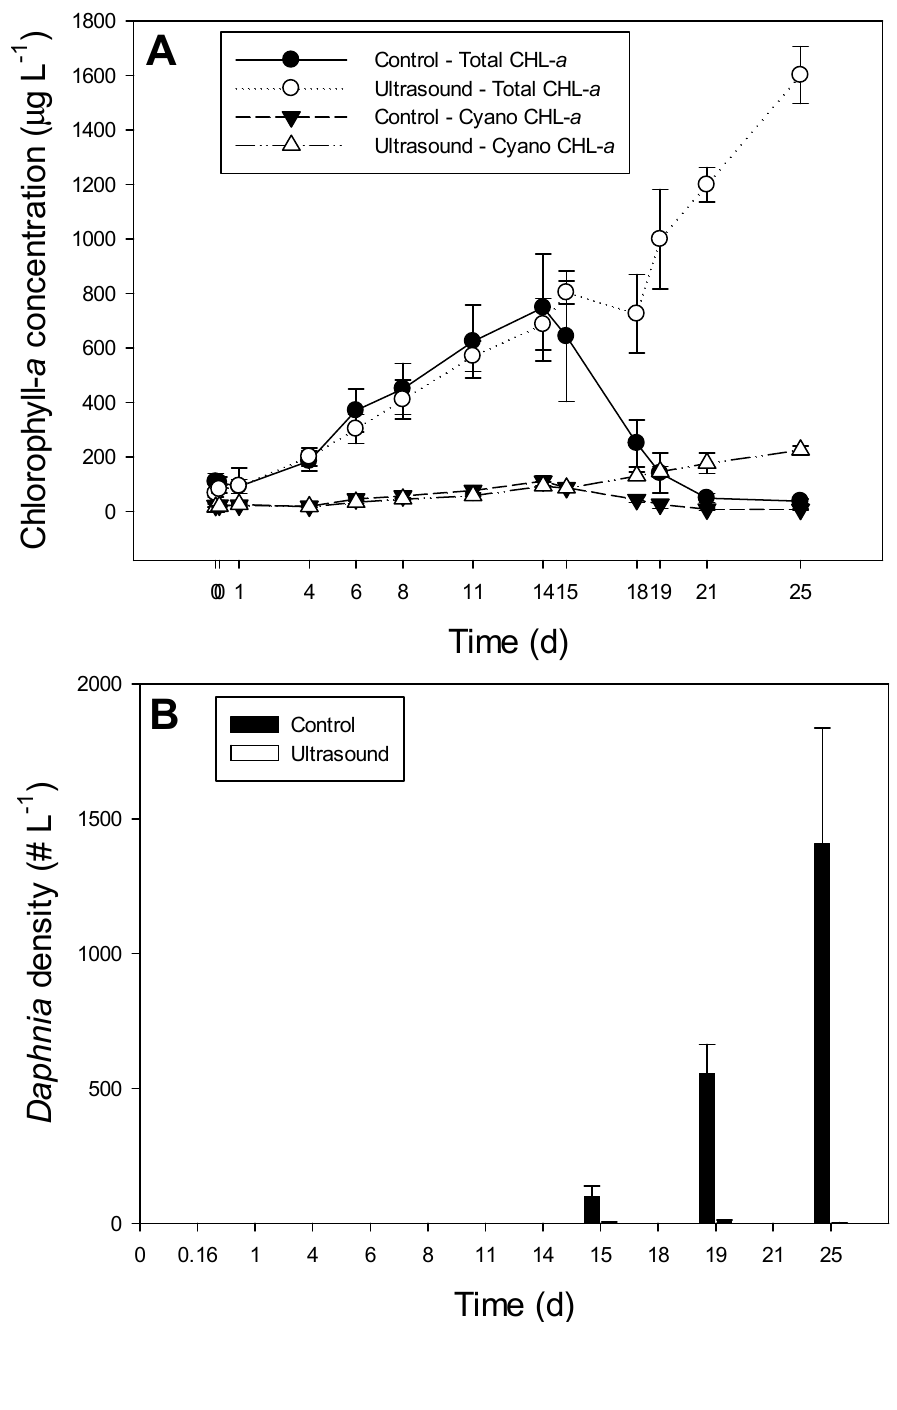
Figure 4. Panel A : Course of total chlorophyll- a concentrations (µg·L − 1 ) in non-exposed plankton communities in 85 L tanks (control; solid circles) and ultrasound treatments (open circles) as well as cyanobacteria chlorophyll- a concentrations in controls (filled triangles) and ultrasound treatments (open triangles). Error bars indicate one standard deviation ( n = 3); Panel B : Course of the density of Daphnia magna (# L − 1 ) in non-exposed 85 L tanks (control; filled bars) and ultrasound treatments (open bars). Error bars indicate one standard deviation ( n =